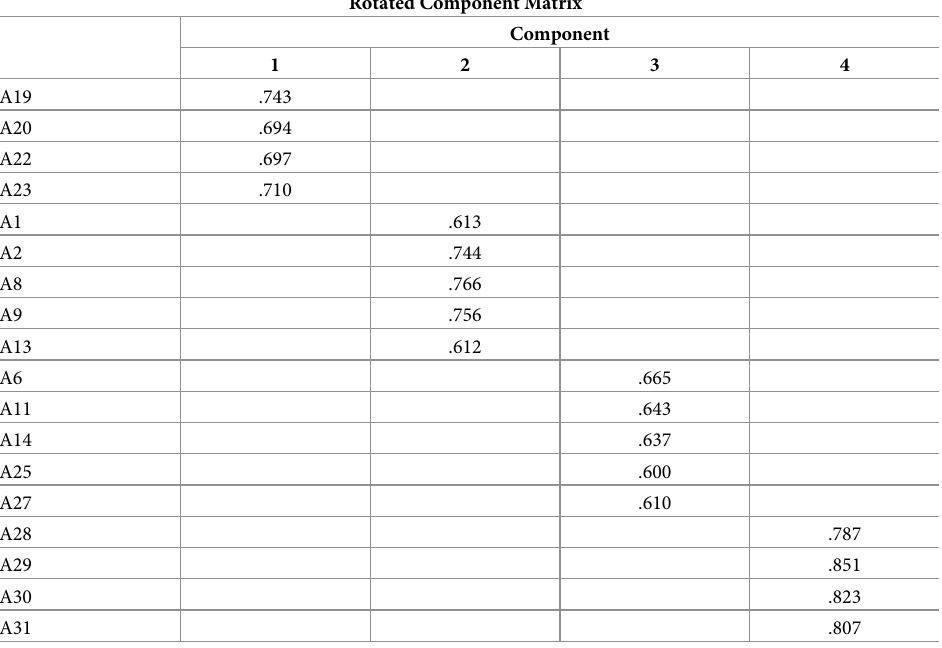
Rotated Component Matrix